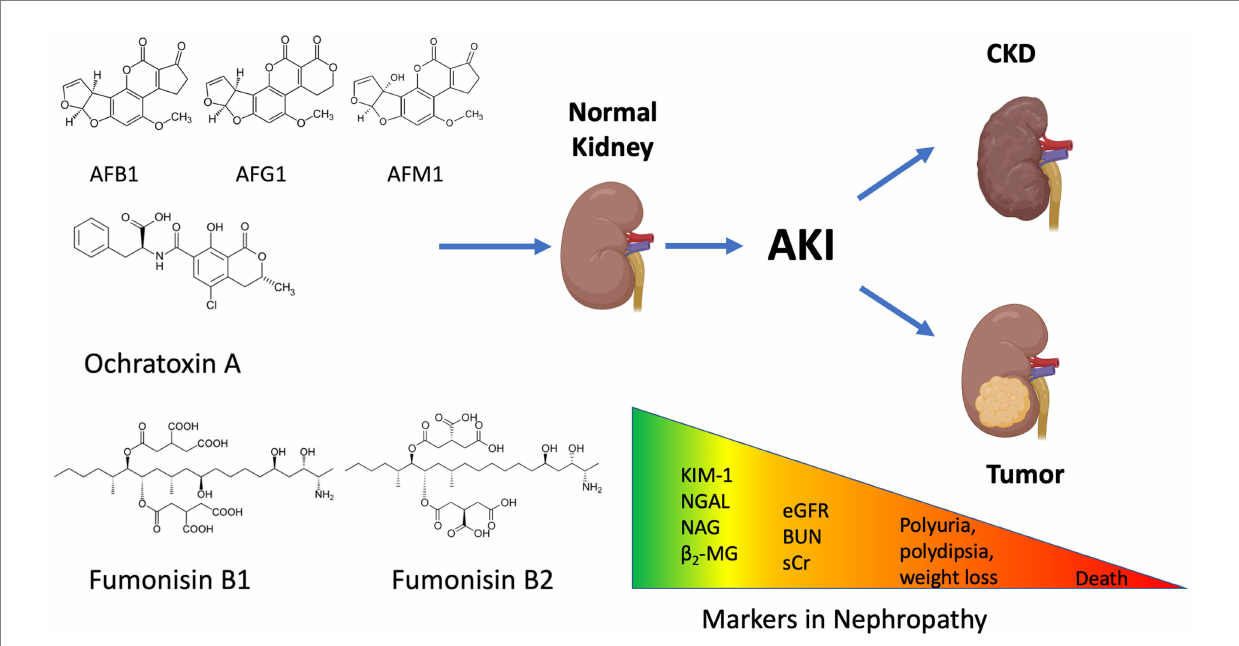
FIGURE 2 Mycotoxin induced nephropathy and the possibilities for intervention. The different types of mycotoxins could cause the deterioration of kidney function. In order to prevent acute kidney injury (AKI), novel kidney biomarkers should be applied to screen the affected animals. Detecting the traditional markers (eGFR: estimated Glomerular Filtration Rate; BUN: Blood Urea Nitrogen; sCr: serum Creatinine) are often too late to act and treat the animals. The figure was created with